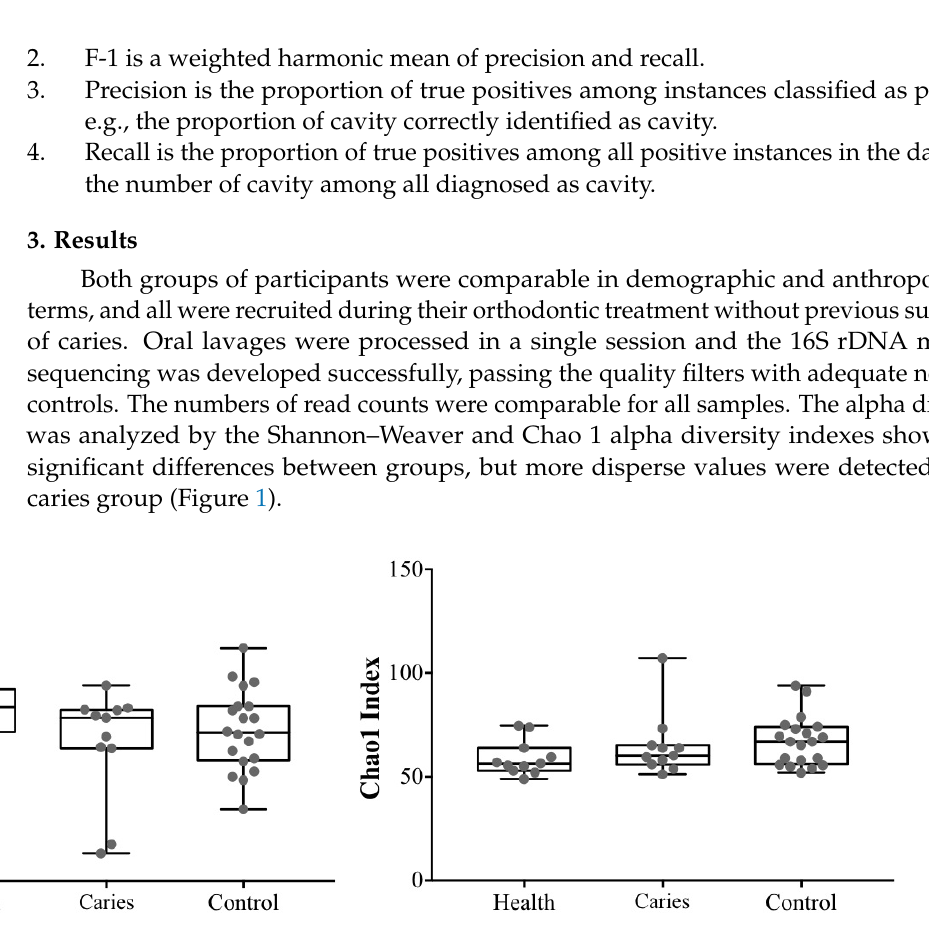
Figure 1. Alpha diversity indexes in all samples. Statistical differences were not